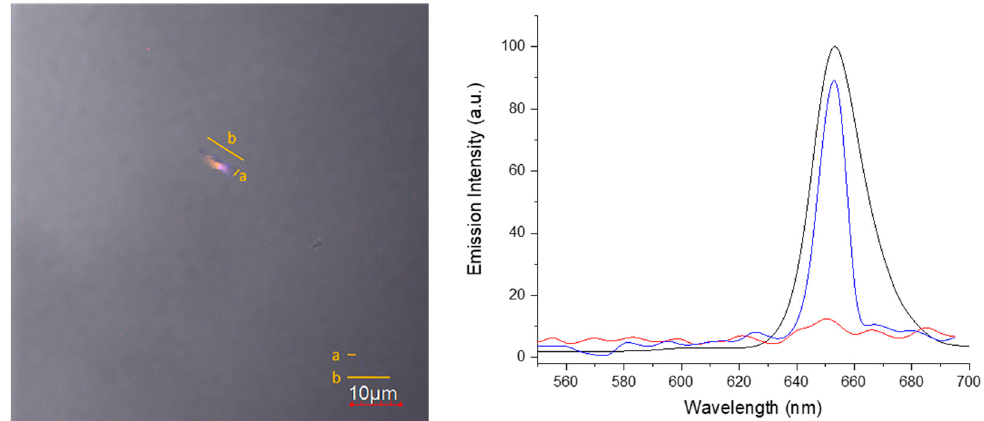
Figure 14. (left ), merged optical bright-field image and confocal micrograph (emission at 650 nm) of a StarP aqueous solution. ( right ), fluorescence emission spectra of the confocal microscopy region of interest with (blue line) and without (red line) StarP aggregate, at λ exc 405 and 543 nm, and the emission profile of the StarP aqueous solution (black line).